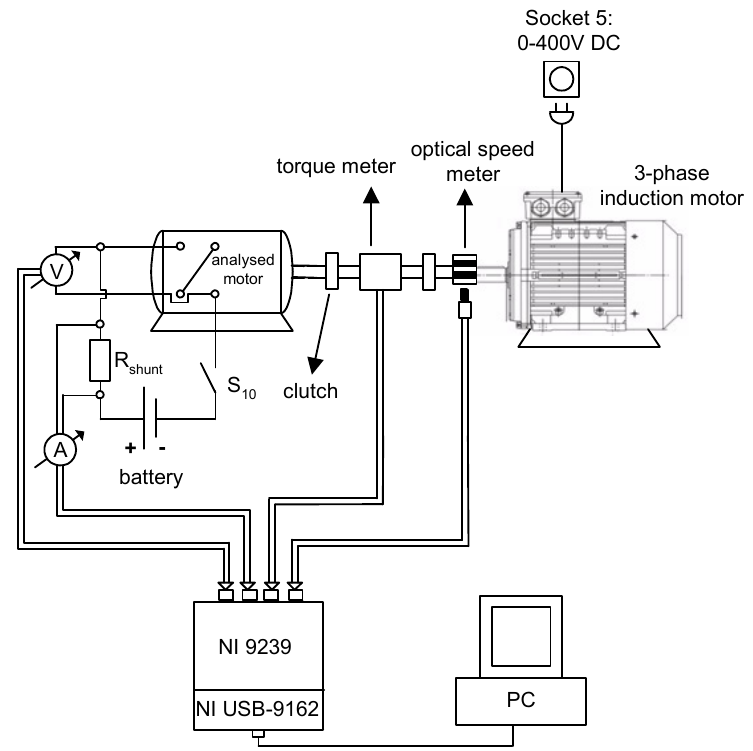
Figure 20. Application of the three-phase induction motor as loading during dynamic tests. Varying the DC supply voltage (0–400 V) of the “load motor”, the braking torque applied on the analyzed motor can be varied.